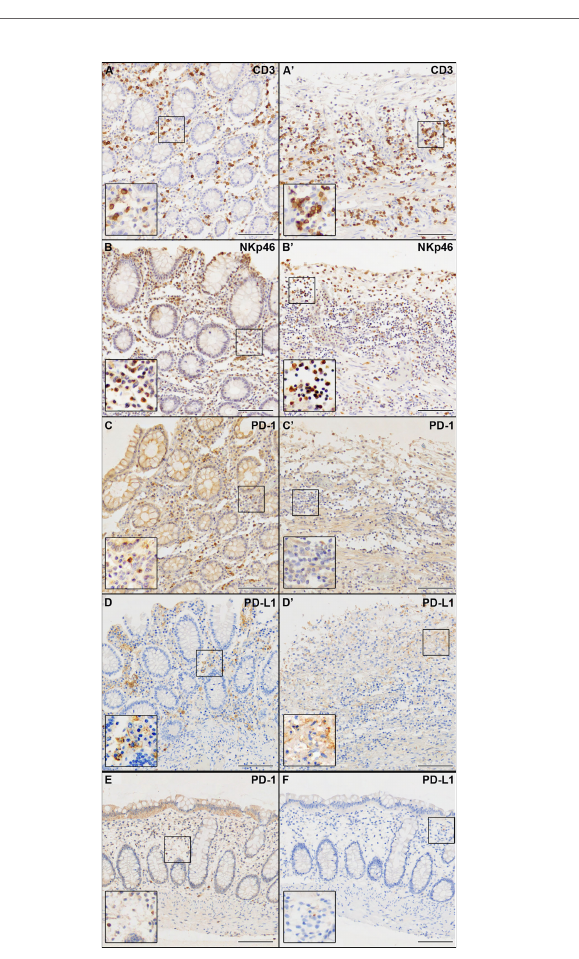
FIGURE 3 | IHC analysis of the immune compartment markers indicated in each panel. (A – D) Non-ulcerated areas of the patient ’ s colon mucosa. (A ’– D ’ ) Ulcerated areas of the patient ’ s colon mucosa. (E, F) Colon mucosa from a healthy patient. Scale bars are 100 µm.